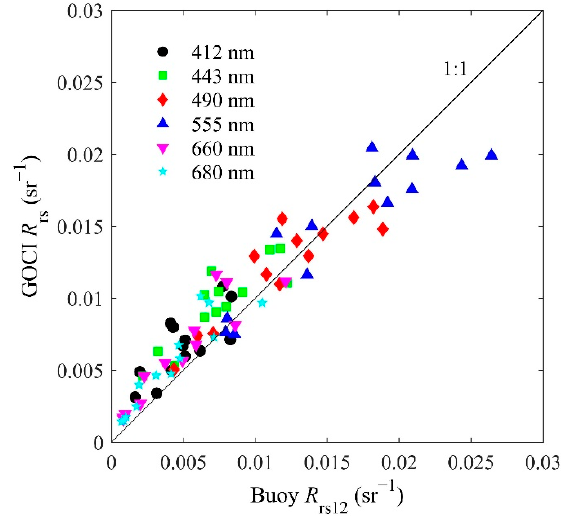
Figure 12. GOCI R rs versus buoy R rs12 at bands of 412, 443, 490, 555, 660, and 680 nm. The black solid line refers to the 1:1 line. Table 3. Statistics for the remote sensing reflectance matchup data between the GOCI L2 R rs and buoy-measured R rs12 . λ